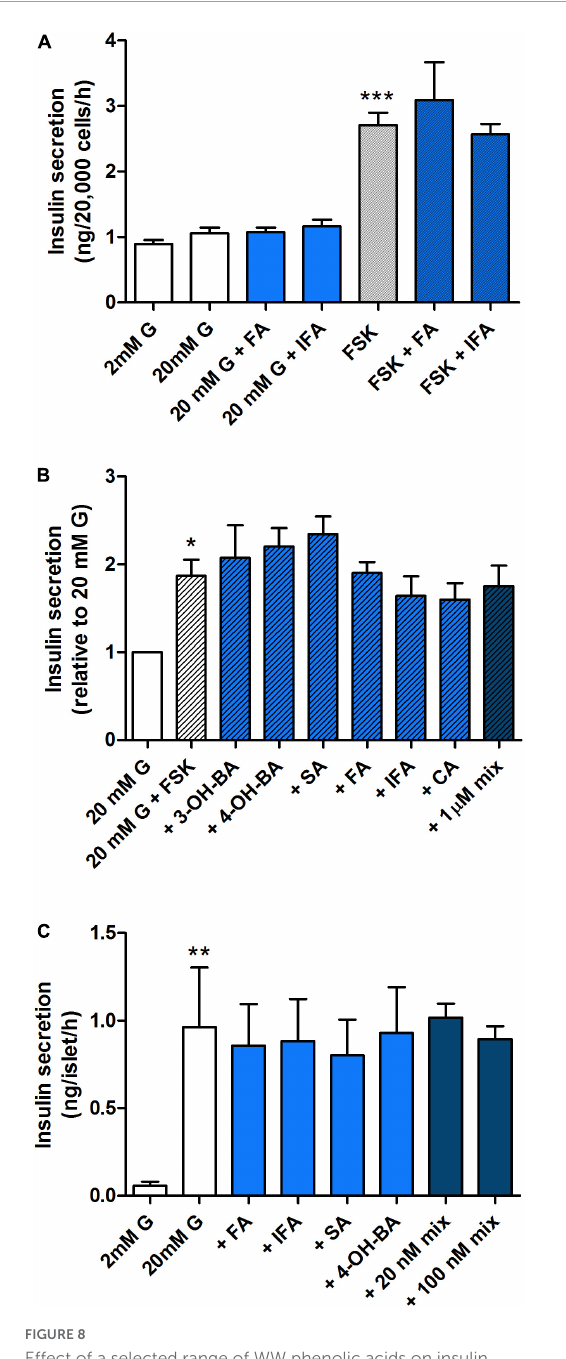
FIGURE7 Effect of fermentation supernatants on insulin secretion from MIN6 beta cells. Cells were stimulated with 2, 20 mM glucose (G) or 20 mM glucose + 500 nM phorbol myristate acetate (PMA) for 1 h with or without 1% fermentation supernatant from control or HFHFr collected at 0 h (A) , 6 h (B) or 24 h (C) as indicated. Data are expressed as mean ± SEM, n = 7 from one experiment representative of 3. NS, non-significant; * P < 0.05, ** P < 0.01, vs. negative control (one-way ANOVA and Bonferroni’s multiple comparison test). CW, Low fiber control wheat; WW, wholegrain wheat; NEG: Slurry only. *** P < 0.001 and **** P < 0.0001.